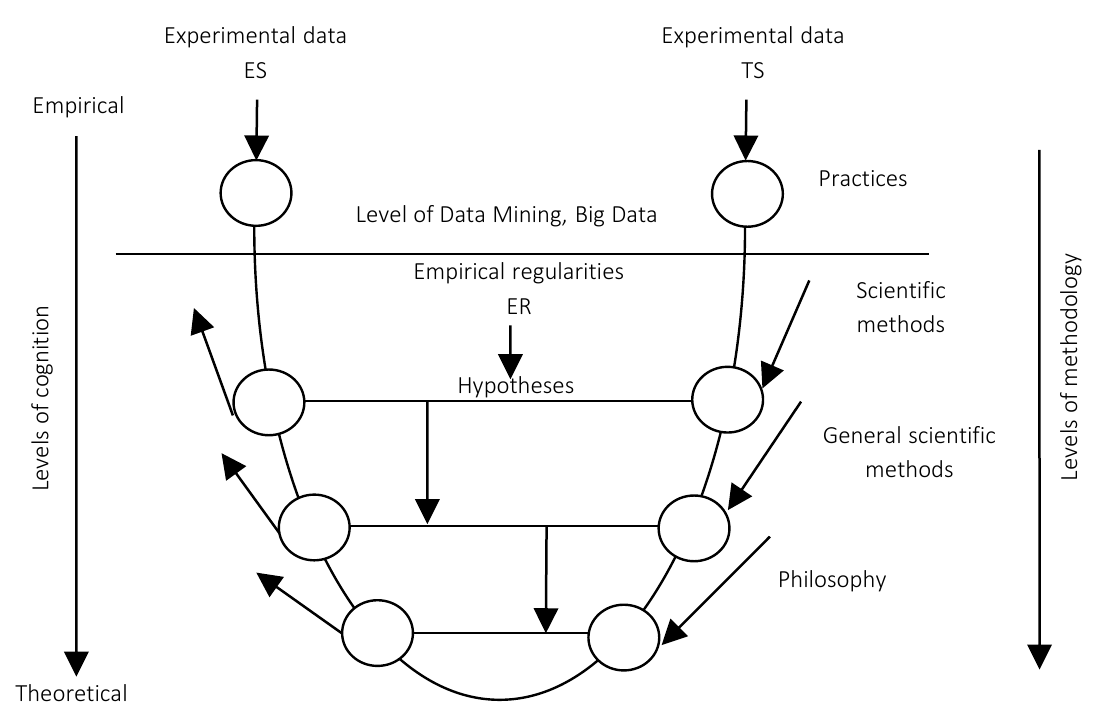
Figure 3. Relationship between the levels of